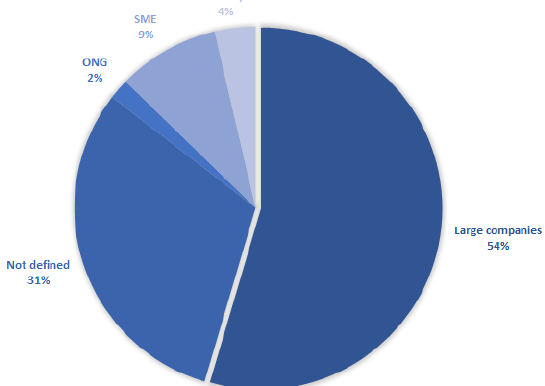
Fig. 2 . Type of organisations that employ the